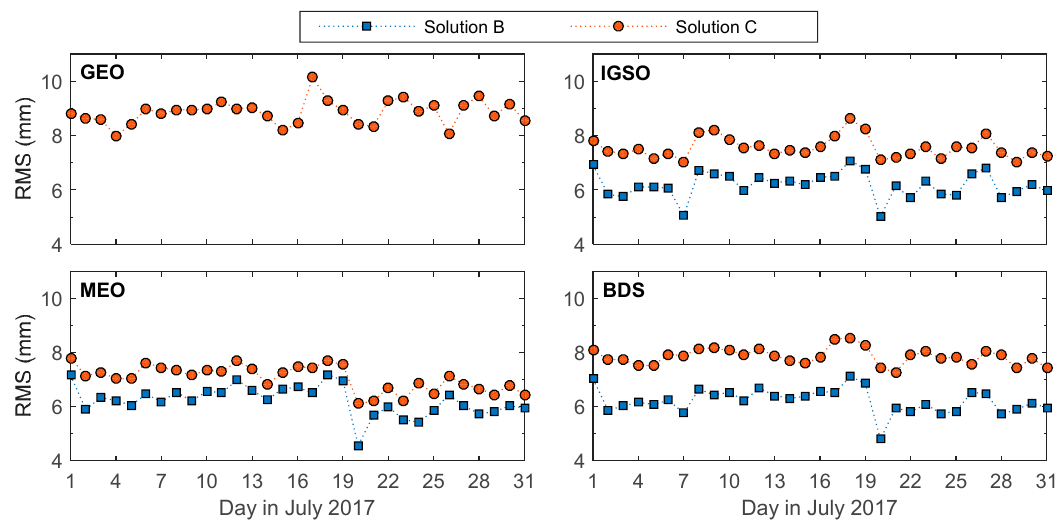
Figure 8. Daily RMS series of phase observation residuals for GEO, IGSO, MEO, and all BeiDou satellites in POD of FY-3C with different solution B and C. The blue squares and red circles represent the daily RMS of residuals obtained in solution B and C, respectively. The upper left, upper right, lower left, and lower right denote for GEO, IGSO, MEO, and all BeiDou satellites, respectively.